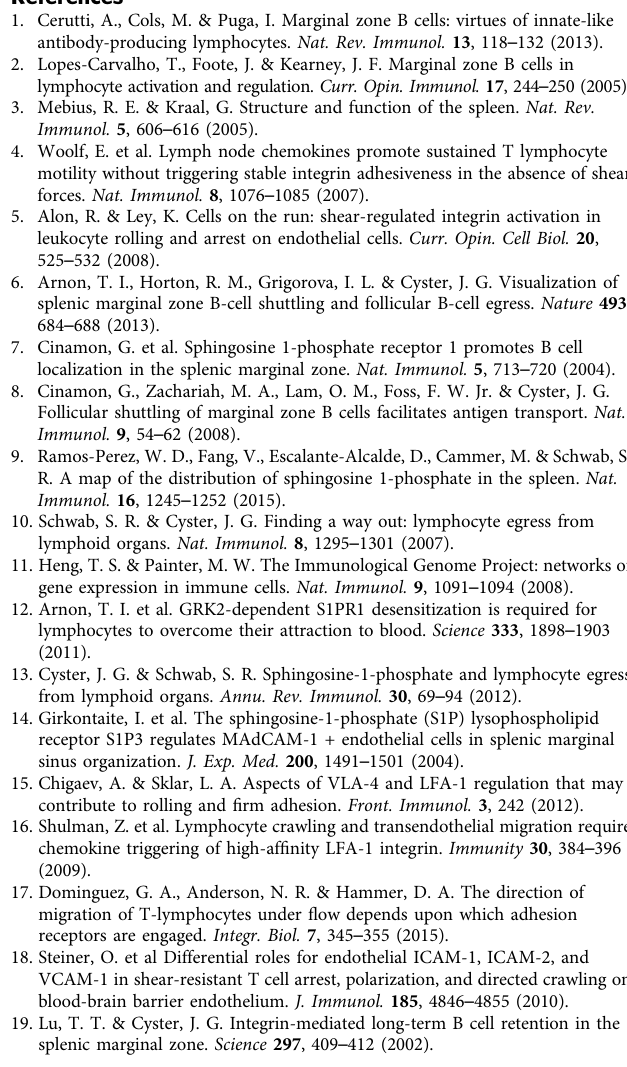
Fig. 9 Model of MZB migration up fl ow with S1P counterforce. a MZBs in spleen shuttle from the marginal zone (MZ) surrounding the follicle (FO) to the inside of the follicle, to carry antigens from blood to the follicular dendritic cells and back again. CXCL13 is required for MZB entry into the follicle, while S1PR1 is required for MZB exit from the follicle. The marginal zone is rich in ICAM-1 while the red pulp contains both ICAM-1 and high levels of VCAM-1. An unknown force drives MZBs toward the follicle. b Flow: Shear fl ow induces MZB migration up the fl ow if ICAM-1 is present. S1P signaling through S1P receptors inhibits MZB migration up fl ow and may trigger LFA-1 integrin re-distribution. S1PR1 is rapidly internalized, thus S1PR3 may be the main counterforce. Upon eventual internalization of S1PR3, MZBs would migrate up the fl ow. MZBs that reach the sinus (elongated green cells) would